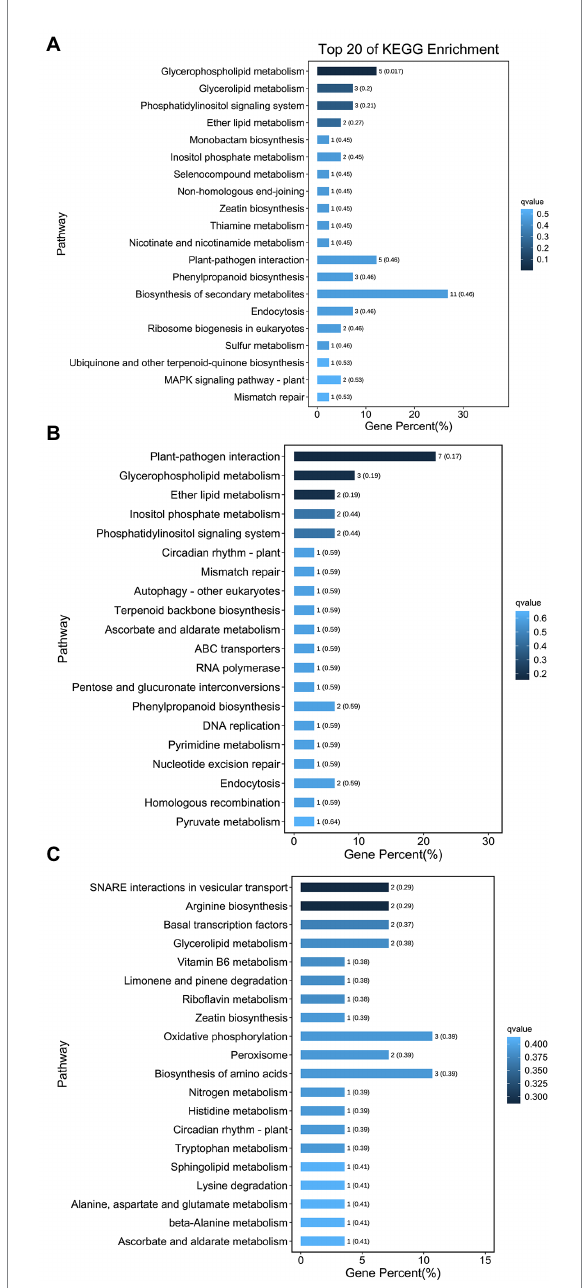
FIGURE 8 Kyoto Encyclopedia of Genes and Genomes (KEGG) analysis of the 20 most enriched pathways from the roots. (A) KEGG analysis for CK vs. UI, (B) BI vs. UI, and (C) CK vs. BI. The coloring of the q -values indicates the significance of the enrichment factors. The Y-axis shows the names of the enriched pathways. The X-axis represents the percentage of enriched